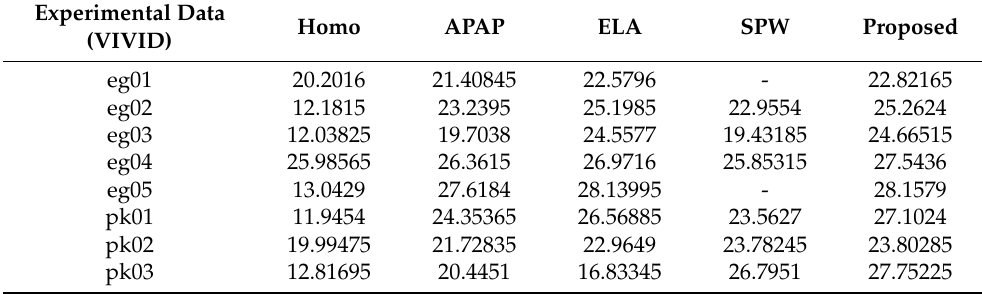
Table 3. PSNR Value